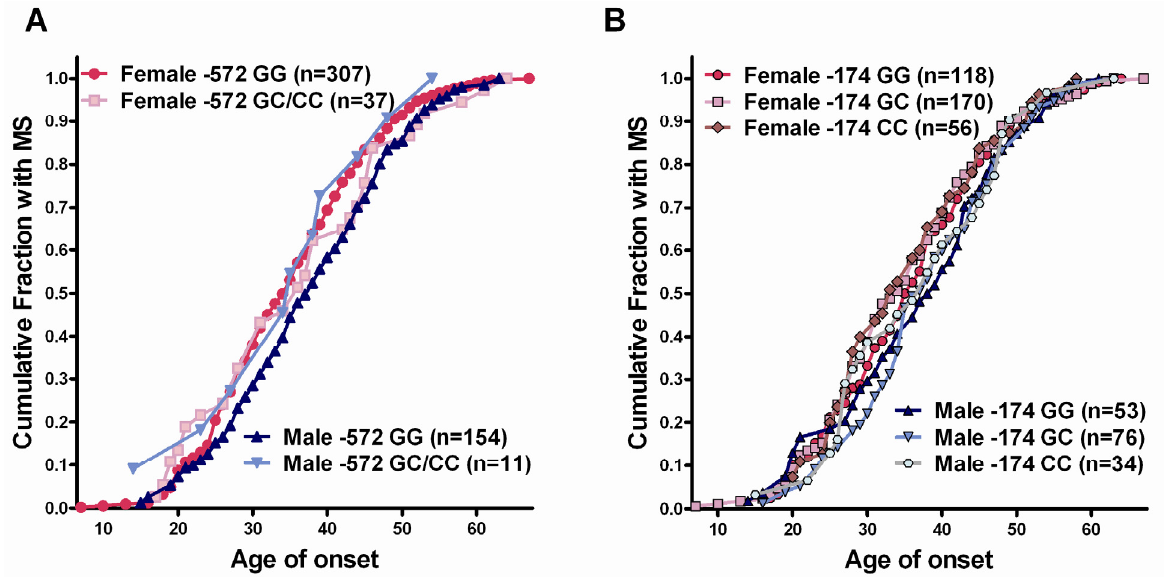
Figure 4. Cumulative fraction of patients carrying different IL6 promoter genotypes vs. age of onset of MS. ( A ) Patients grouped according to − 572 IL6 genotype; ( B ) Patients grouped according to − 174 IL6